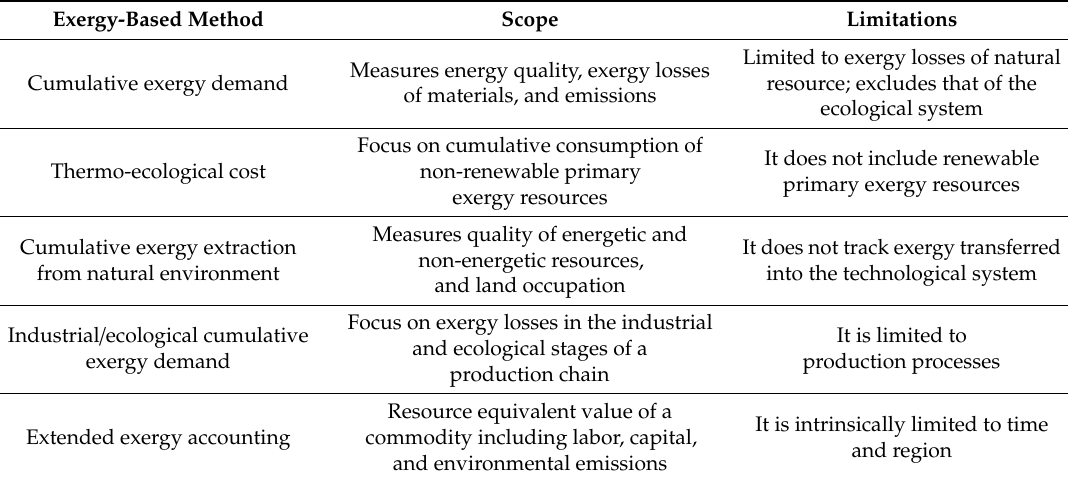
Table 2. Comparison of the exergy-based